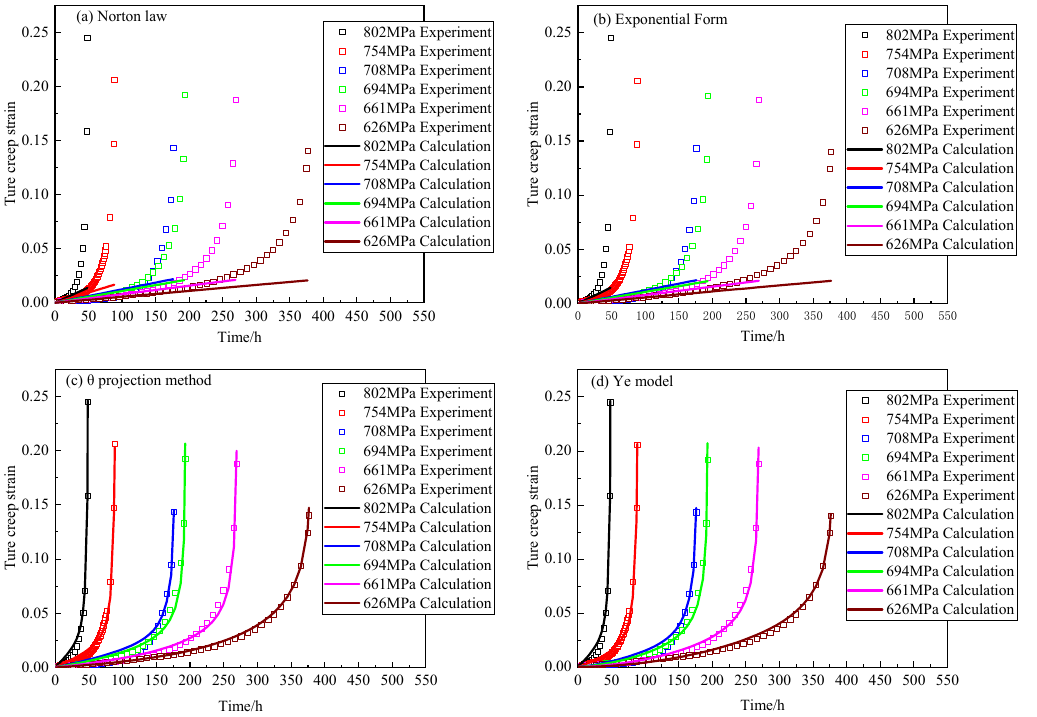
Figure 8. Creep constitutive models fitting results: ( a ) Norton law; ( b ) Exponential form; ( c ) θ projection method; ( d ) Ye model.